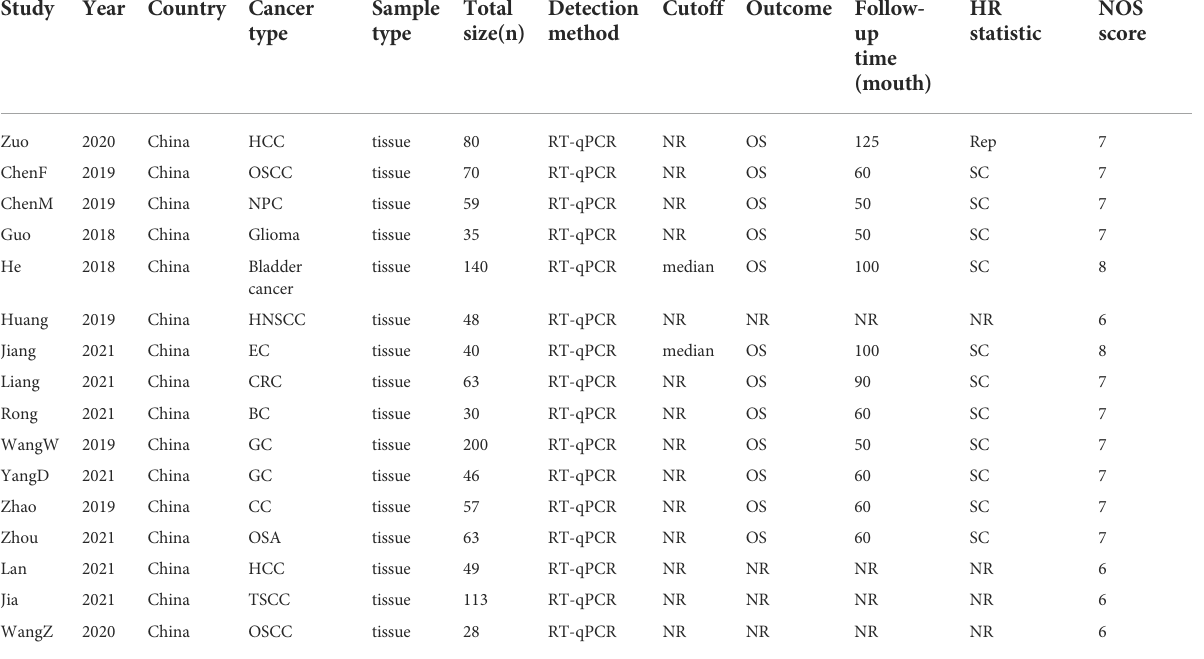
TABLE 1 Characteristics of studies in this